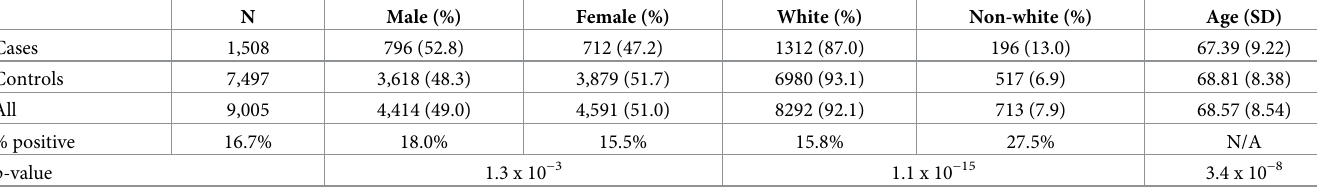
Table 1. Demographics—Sex, ancestry and age.